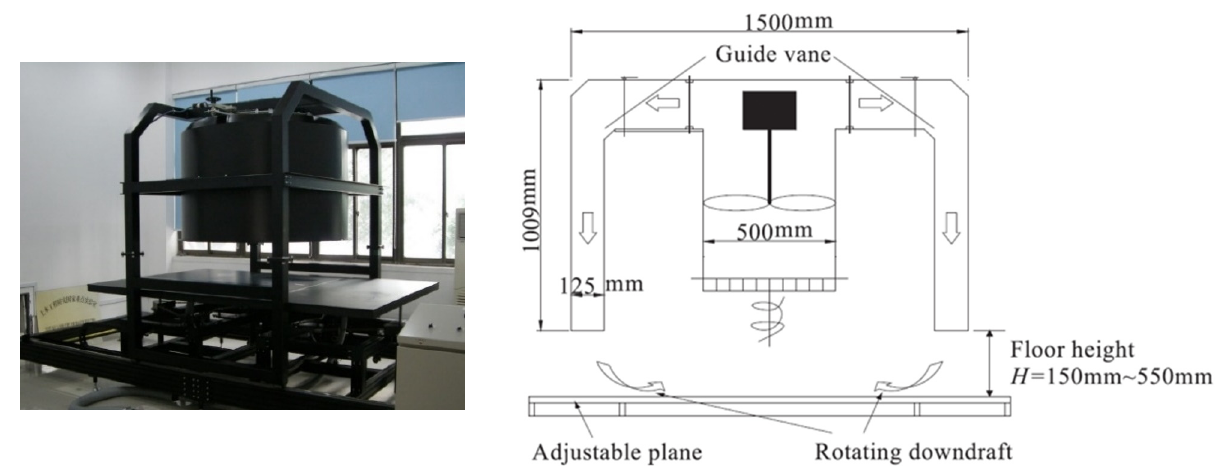
Figure 2. Tornado simulator at Tongji University.